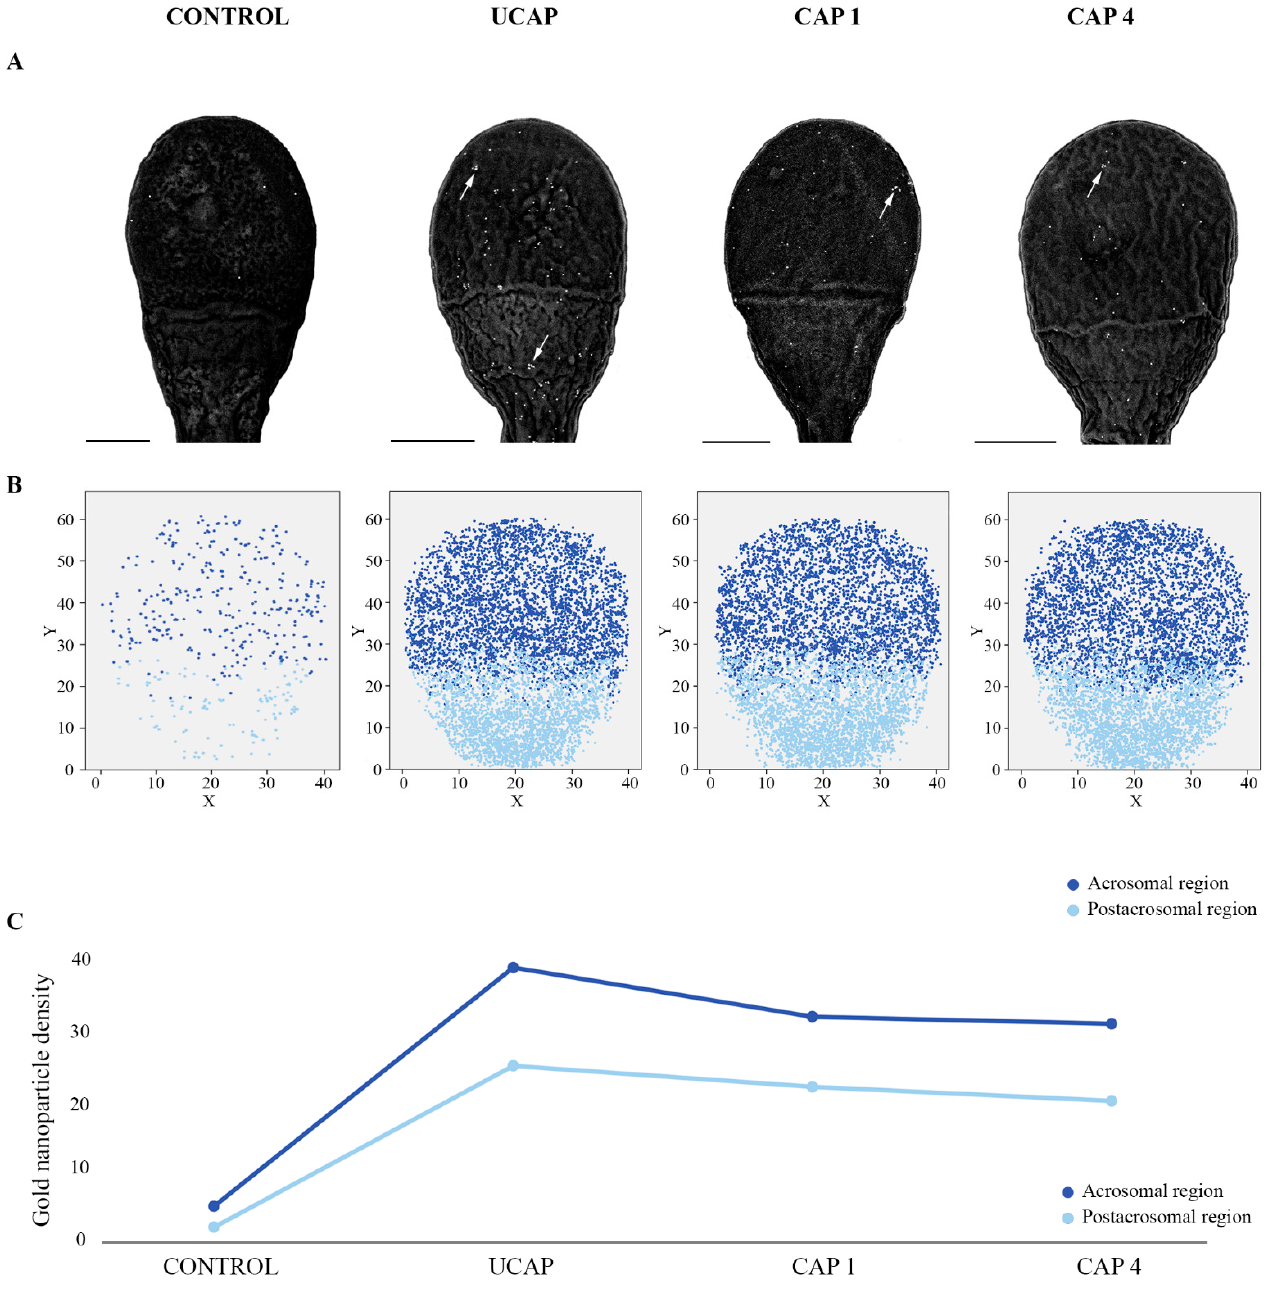
Figure 1. ( A ) Sperm FE-SEM micrographs of terminal and linked fucose recognized by AAA lectin in control by the inhibitory sugar test (CONTROL), uncapacitated (UCAP), one hour capacitated sperm (CAP1), and four hour capacitated sperm (CAP4). Note the presence of distinct clusters in all sperm conditions (white arrows). Scale bar of 1 µm common to all micrographs. ( B ) Topographical distribution maps resulting from the overlapping of fucosyl residues counts and position following a Cartesian coordinate system of 60 cells in control by the inhibitory sugar test and 105 cells for each UCAP, CAP1 and CAP4 conditions. ( C ) Trend graph showing the density after the incubation with the inhibitory sugar and the decrease in fucose residues in both acrosomal and postacrosomal regions during the in vitro capacitation time (1 and 4 h).